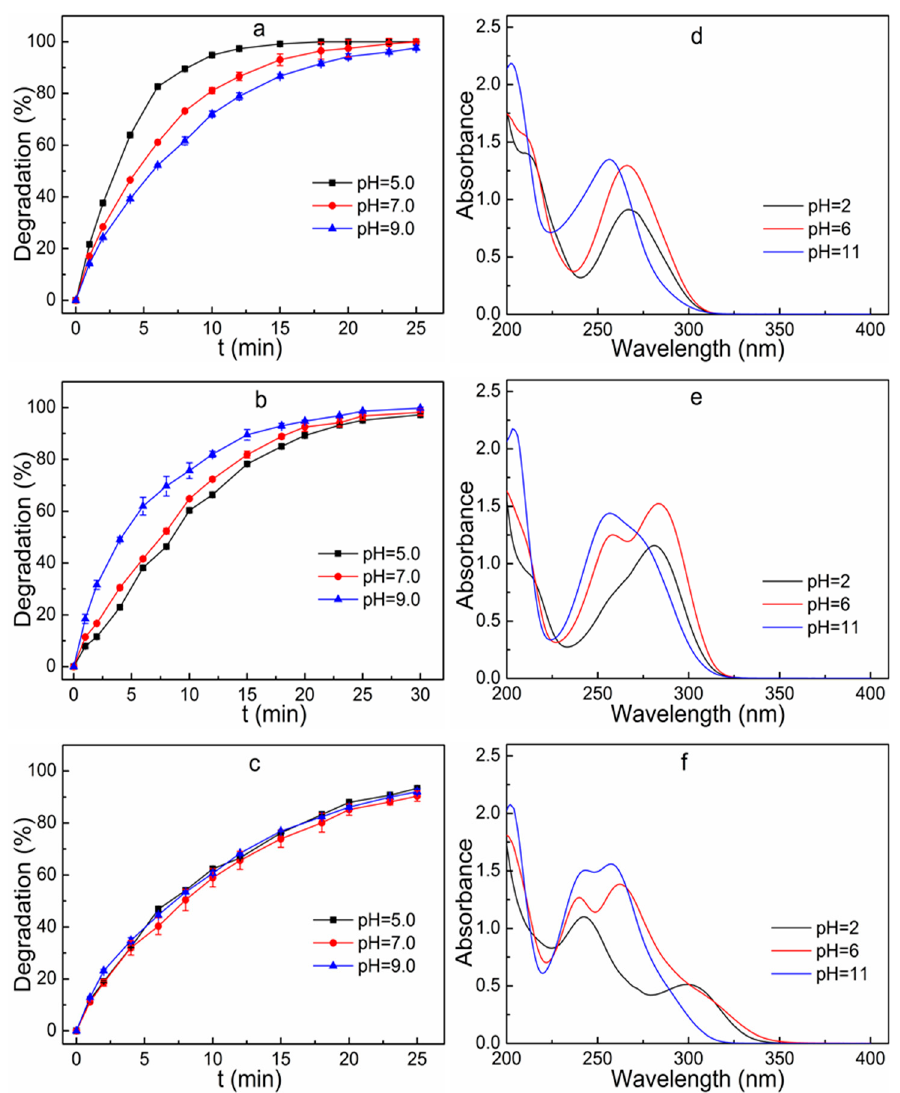
Figure 5. Degradation of SMZ ( a ), STZ ( b ) and SMT ( c ) in different pH and UV spectra of SMZ ( d ), STZ ( e ) and SMT ( f ) under different pH conditions. Reaction conditions: initial concentration of the mixed solution 100 μ g L − 1 , UV light intensity 5 W, H 2 O 2 dosage 55 mg L − 1 .